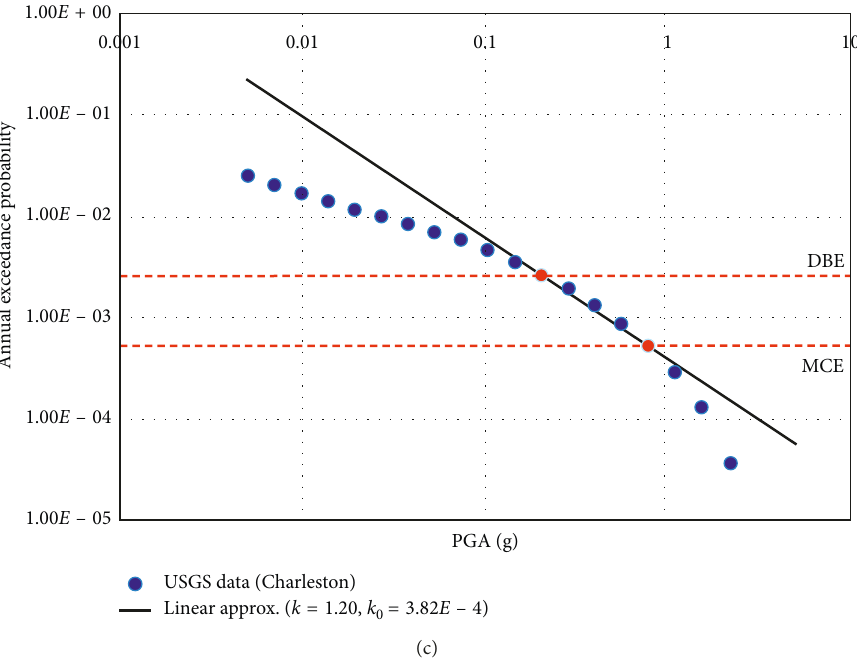
Figure 15: Seismic hazard curves for (a) Los Angeles, (b) Memphis, and (c) Charleston.